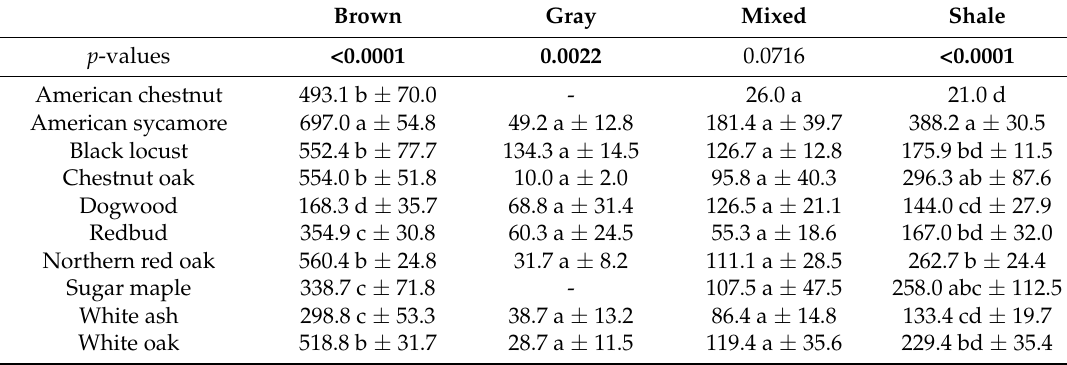
Figure 4. Average tree height (cm) for each species across brown sandstone plots only. Error bars represent ± SE. Means with different letters are significantly different ( p < 0.05). AC = American chestnut, AS = American sycamore, BL = black locust, CO = chestnut oak, DW = dogwood, RB = redbud, RO = northern red oak, SM = sugar maple, WA = white ash, WO = white oak.